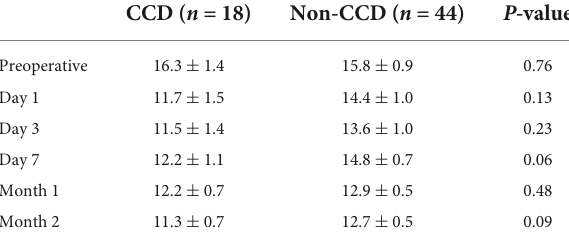
TABLE 4 Time course of IOP in eyes with or without